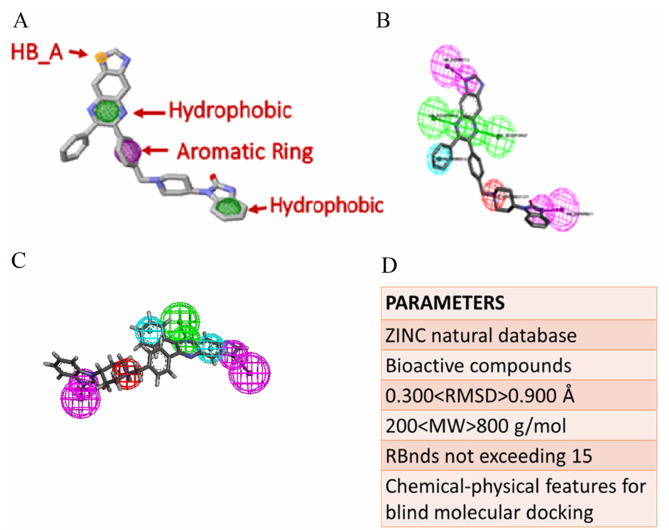
Figure 3. Pharmacophore models and data base screening. ( A ) The pharmacophore model built by Pharmit on the AKT1-IQO complex. ( B ) The pharmacophore model built by DiscoveryStudio on the AKT1-IQO complex. ( C ) The final pharmacophore model generated by DiscoveryStudio for the virtual screening. ( D ) The parameters used for the virtual